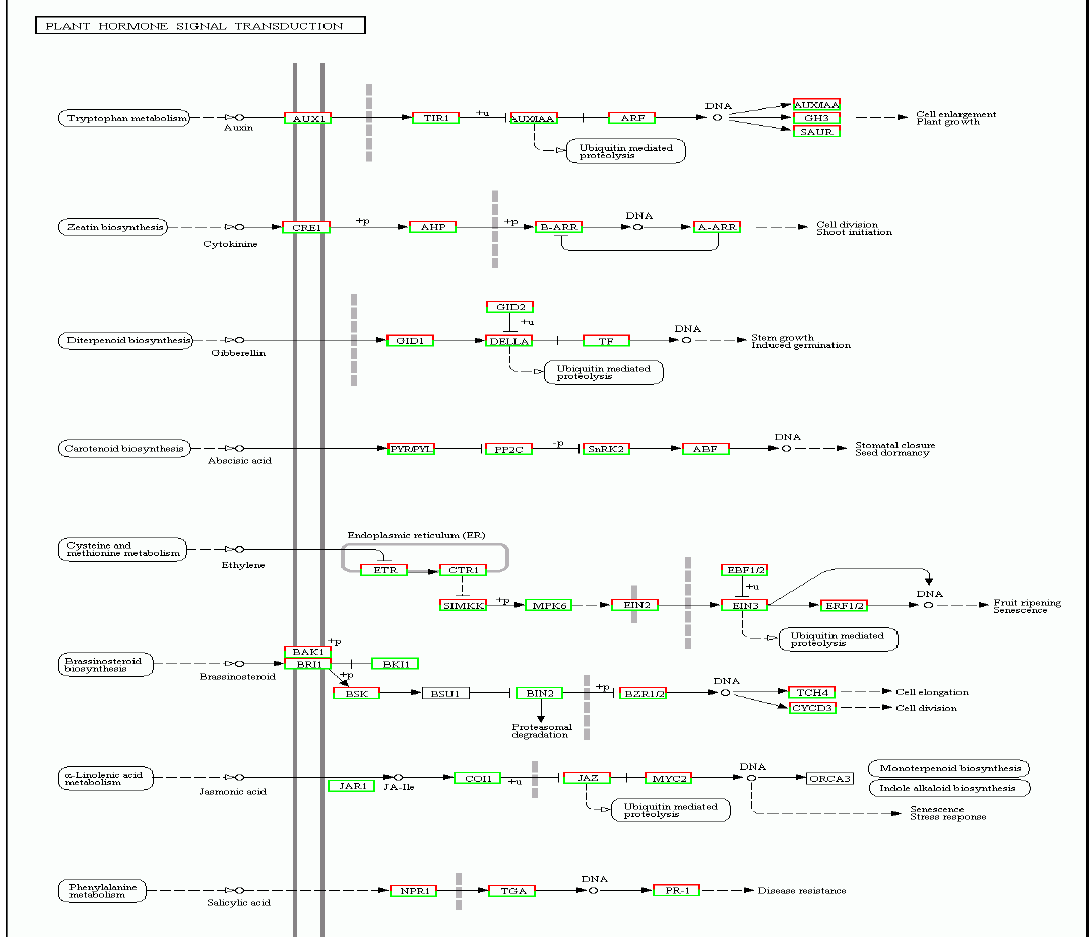
Figure 11. The cold tolerance genes of tea plants involved in metabolism of plant hormone signal transduction pathways.Red boxes representing the upregulation of genes and green ones representing their downregulation.